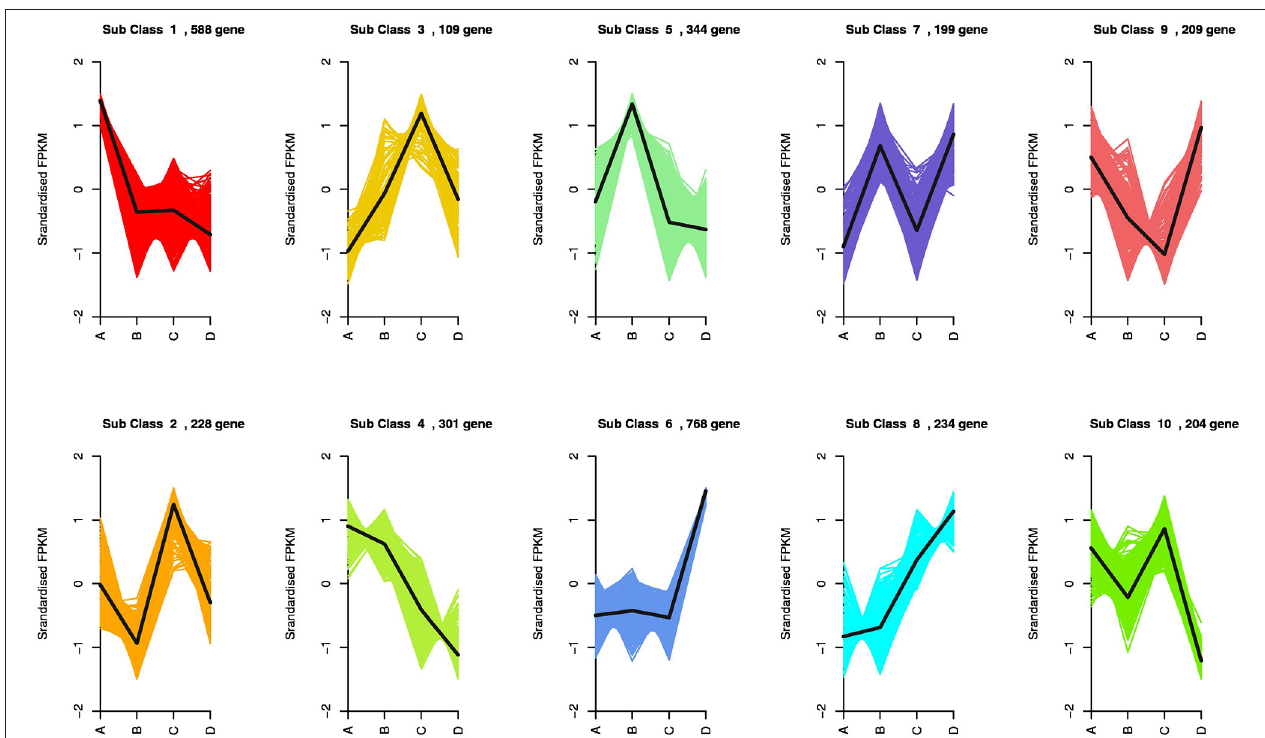
FIGURE 9 | Expression model of DEGs across a series of VPD ranges. A, B, C, and D in the X-axis in the figures represent 0.5, 1.5, 2.5, and 3.5 kPa,